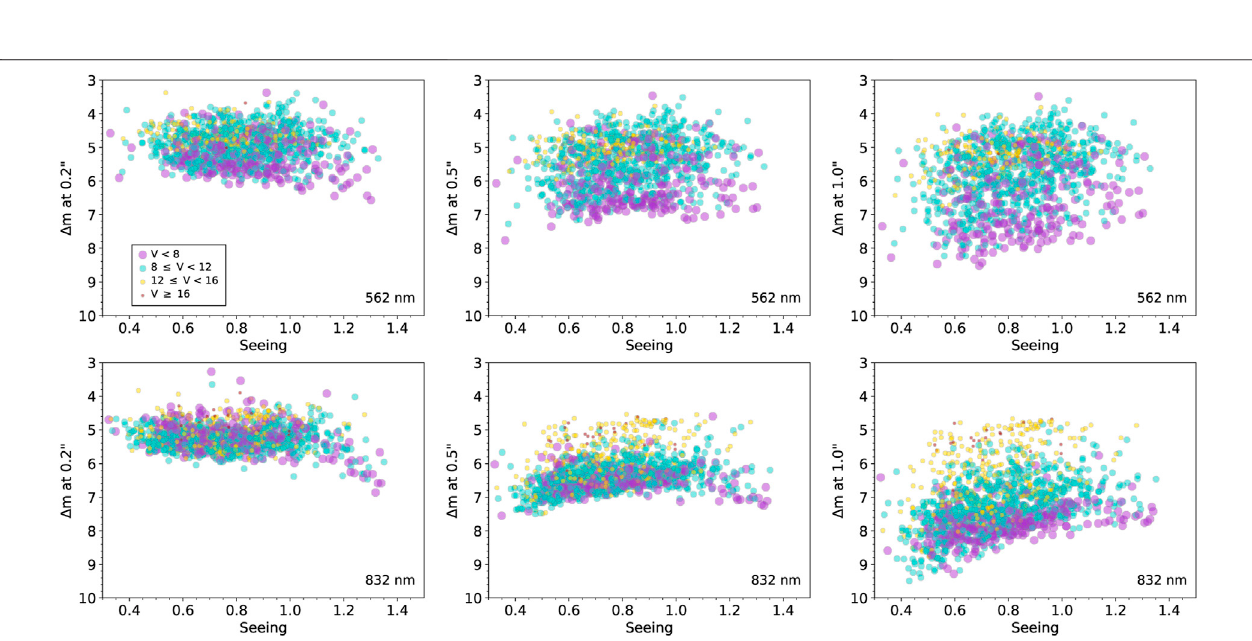
FIGURE 4 | Similar to Figure 3 , but showing the results from Zorro